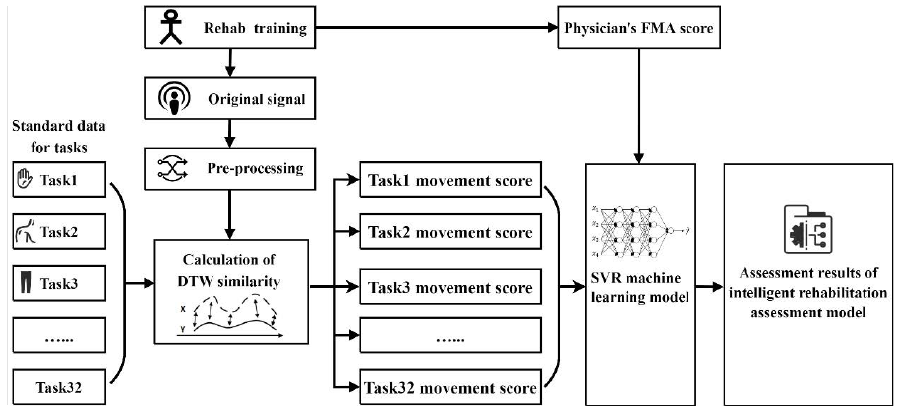
Figure 2. Establishment process of machine learning rehabilitation assessment model.